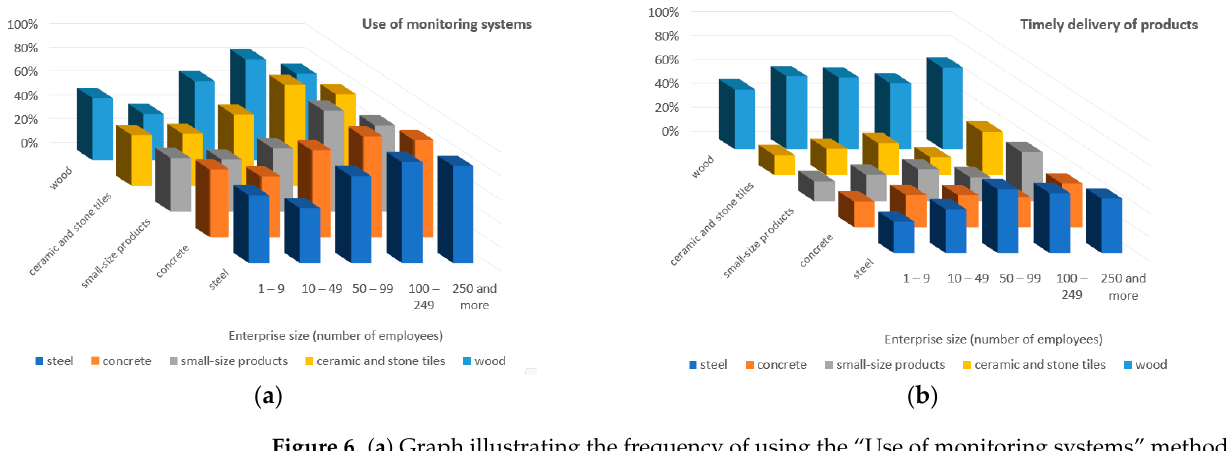
companies of various sizes. ( b ) Graph illustrating the frequency of using the “Timely delivery of